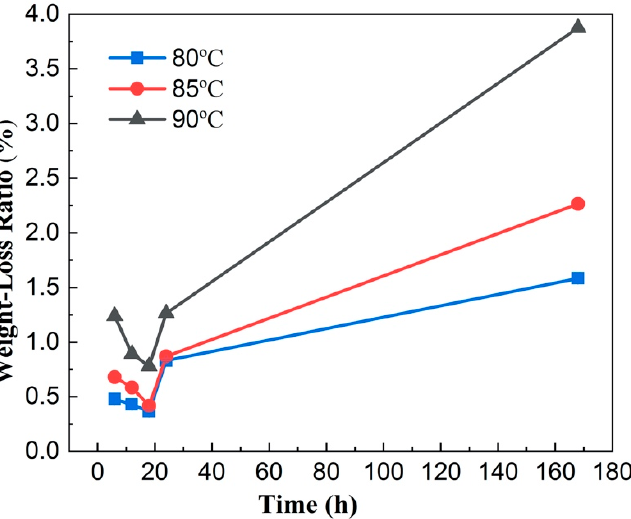
Figure 1. Weight-loss ratio of basalt fiber after soaking in seawater solution for 168 h at 80 °C, 85 °C, and 90 °C. The error bars are within the size of symbols.